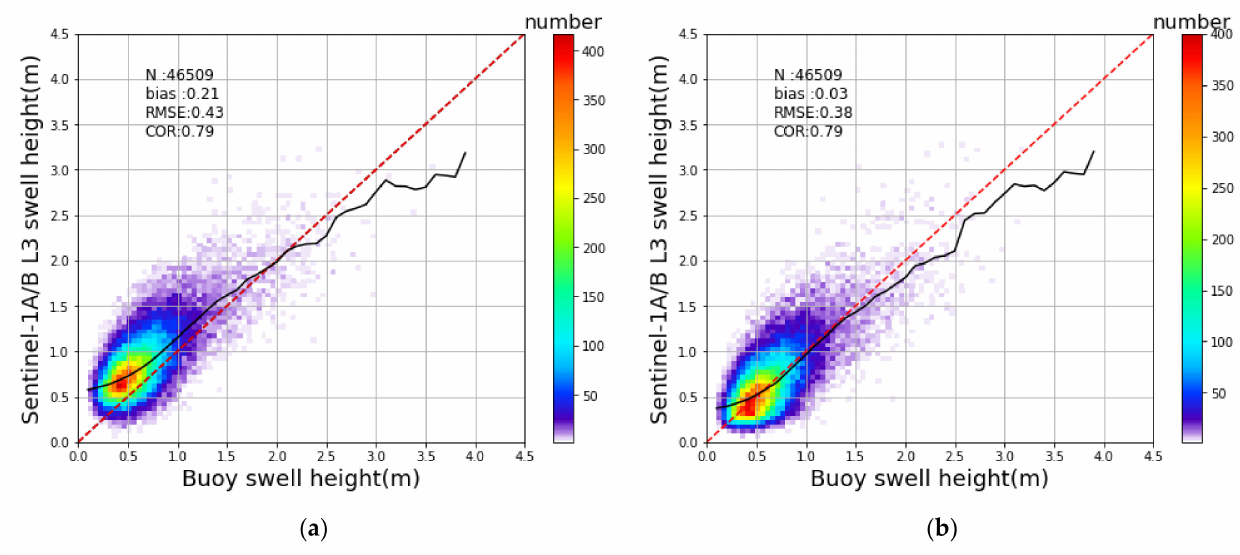
Figure 15. Intercomparisons of the partitioned swell heights for S-1A/B Level-3 versus buoys. ( a ) Original Level-3 SAR products from CMEMS, and ( b ) corrected using Equation